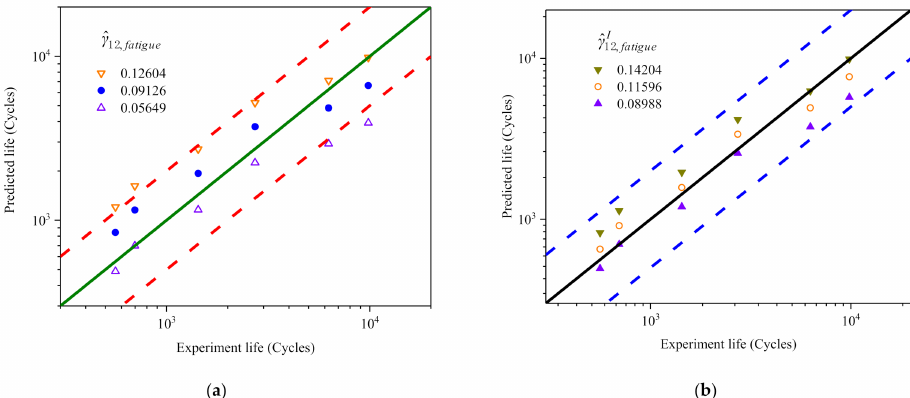
Figure 15. ( a , b ) Comparison between prediction and test of the parameters ˆ γ intermediate and minimum values of their critical values are used as the criterion of fatigue damage. Strain amplitude √ γ a / 3: 0.9%, 0.8%, 0.7%, 0.6%, 0.5% and